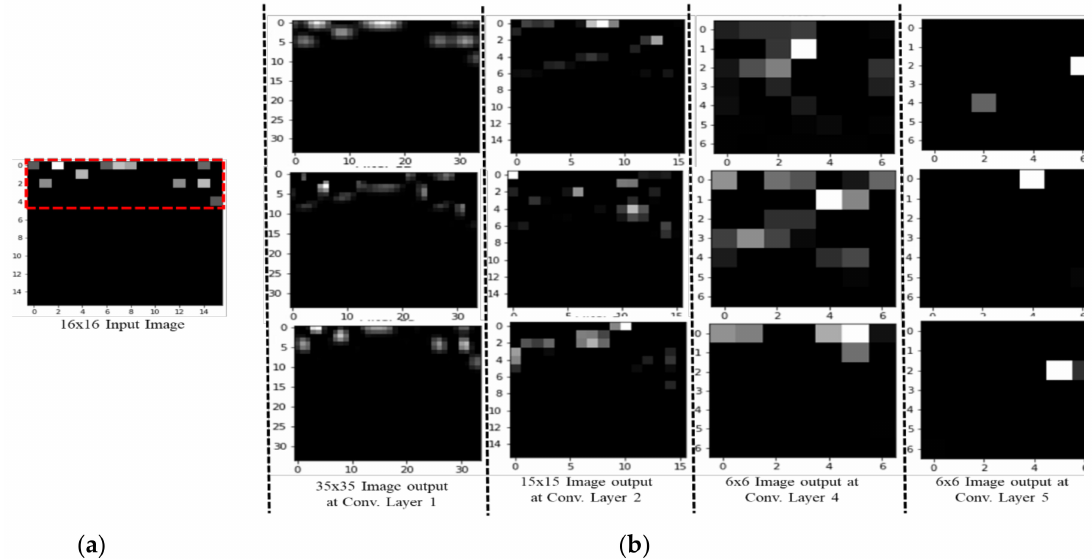
Figure 5. Images for AlaxNet. ( a ) Input image. ( b ) Output image with di ff erent convolutional